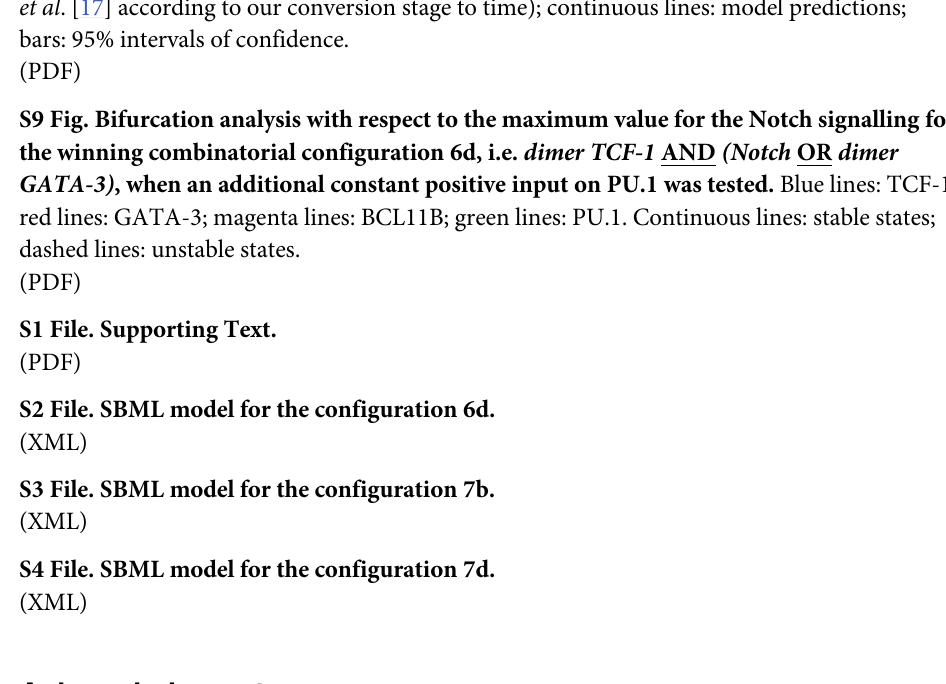
S8 Fig. Winning model predictions for PU.1. Dots: data points (adapted from Mingueneau et al . [17] according to our conversion stage to time); continuous lines: model predictions; bars: 95% intervals of confidence. (PDF) S9 Fig. Bifurcation analysis with respect to the maximum value for the Notch signalling for the winning combinatorial configuration 6d, i.e. dimer TCF-1 AND (Notch OR dimer GATA-3) , when an additional constant positive input on PU.1 was tested. Blue lines: TCF-1; red lines: GATA-3; magenta lines: BCL11B; green lines: PU.1. Continuous lines: stable states; dashed lines: unstable